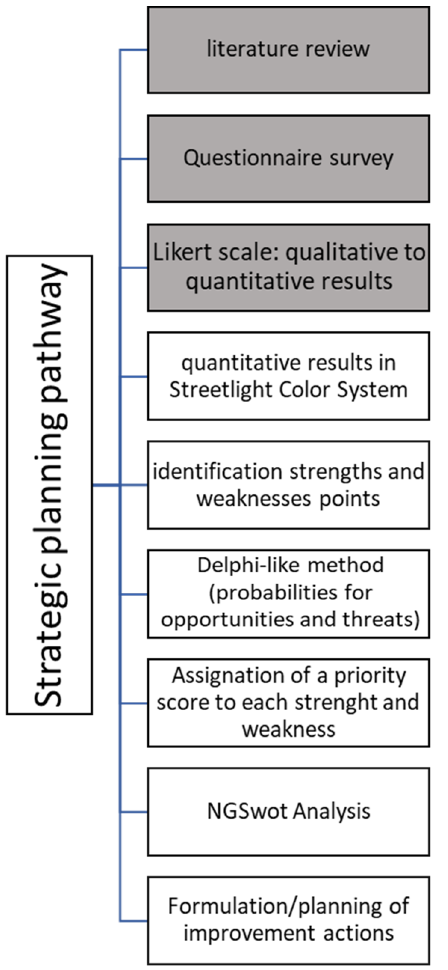
Figure 1. Workflow chart. The gray squares indicate the methodology of the first study published by the authors [14].